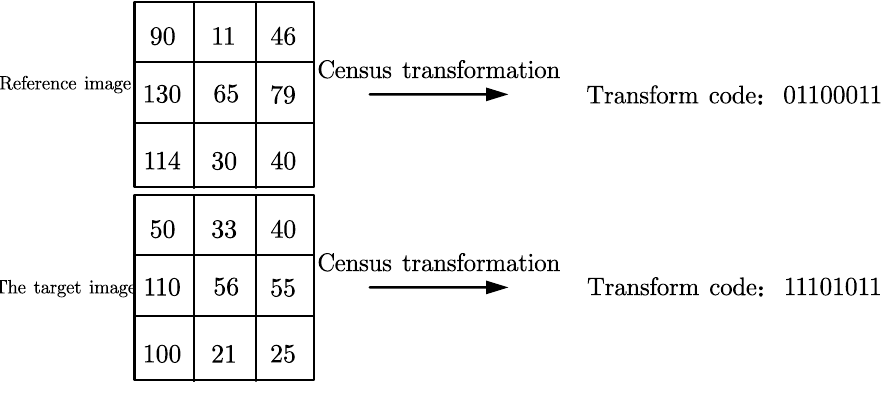
Figure 1. Census transformation process.